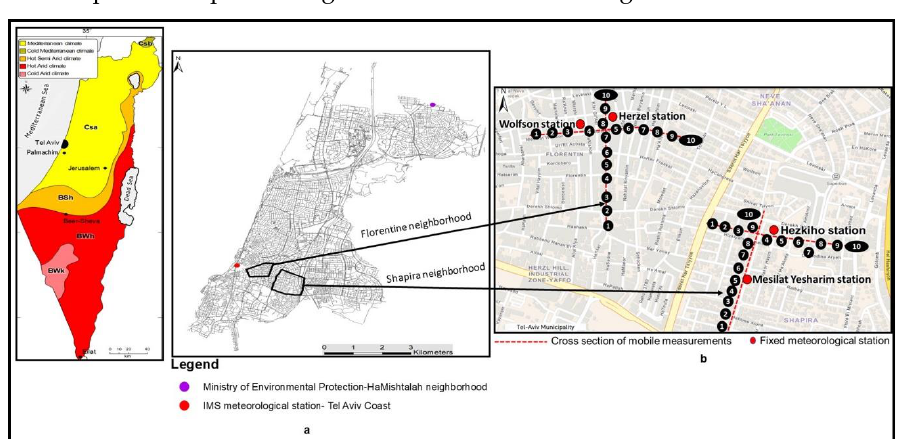
Figure 1. Study site location: ( a ) Map of Tel Aviv with the location of the investigated sites ( b ) Shapira Neighborhood and Florentine Neighborhood and the location of fixed meteorological stations and the location of cross-section of mobile measurements [37].